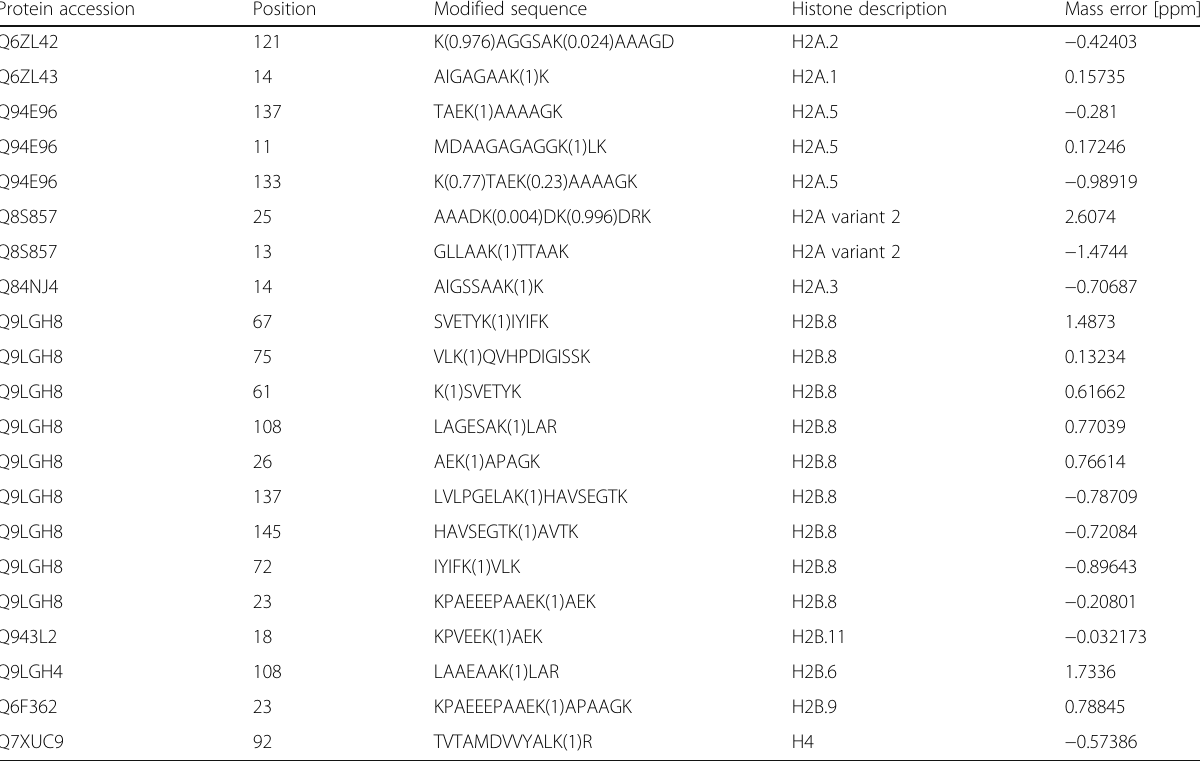
Table 1 Lysine 2-hydroxyisobutyrulated sites identified in histones Protein accession Position Modified sequence